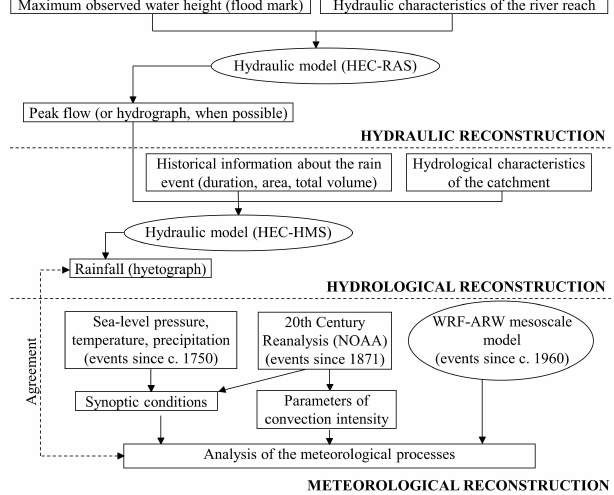
Figure 4. Overview of the multidisciplinary reconstruction method- ology of historical floods (own